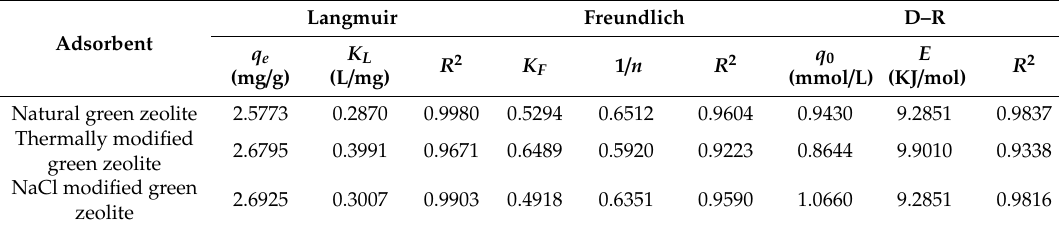
Table 3. Adsorption isotherm parameters of three kinds of zeolite onto nitrogen.